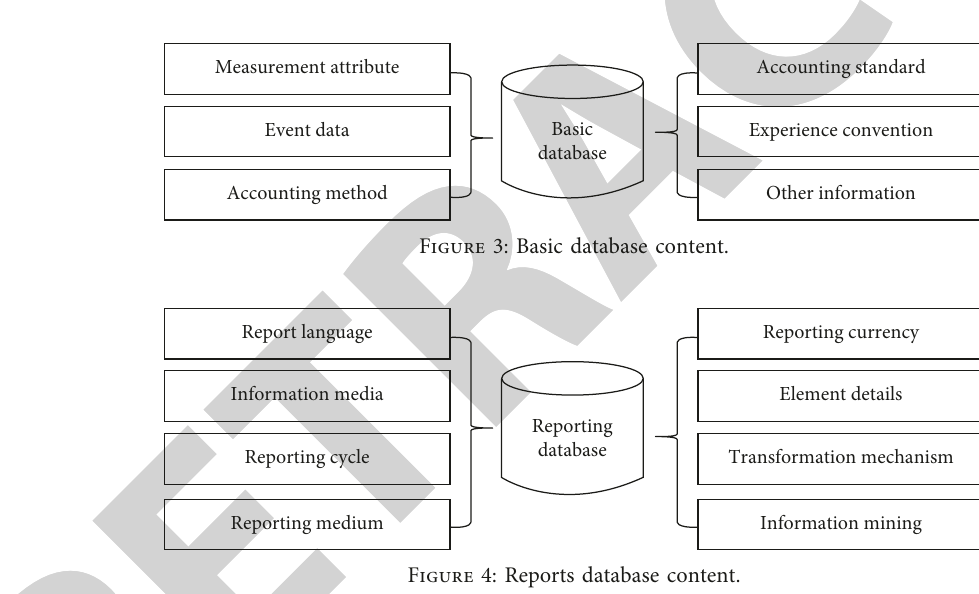
Figure 2: Financial reporting mode in multimedia environment.